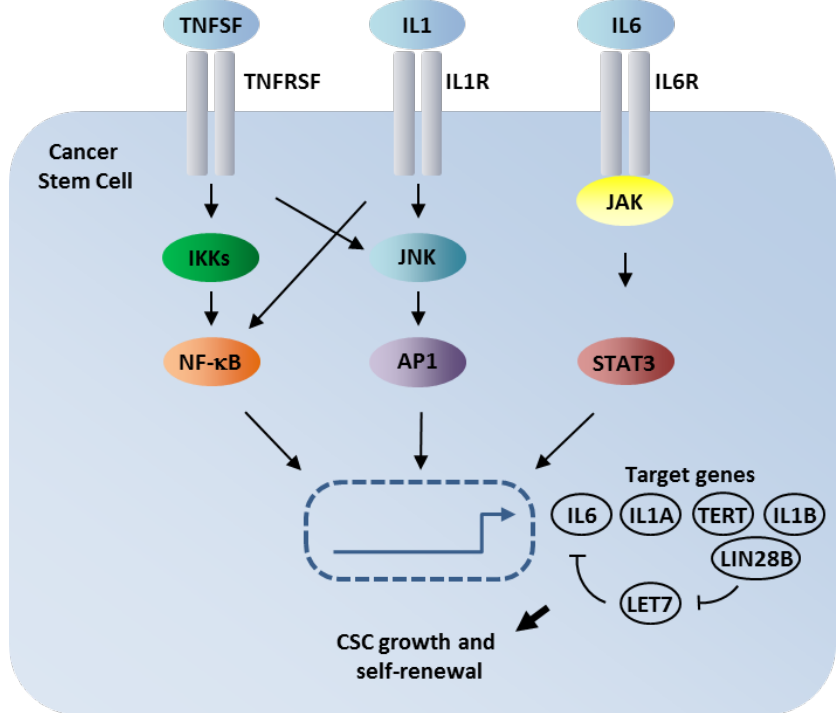
Figure 2. Inflammatory signaling pathways cross-coupled to NF-κB in human cancers. Two pathways (NF-κB and STAT3) were directly activated by epigenetic mechanisms in breast CSCs. Data suggest a high correlation of pro-inflammatory signaling and tumor progression. For further details, see respective text (modified from [25]).